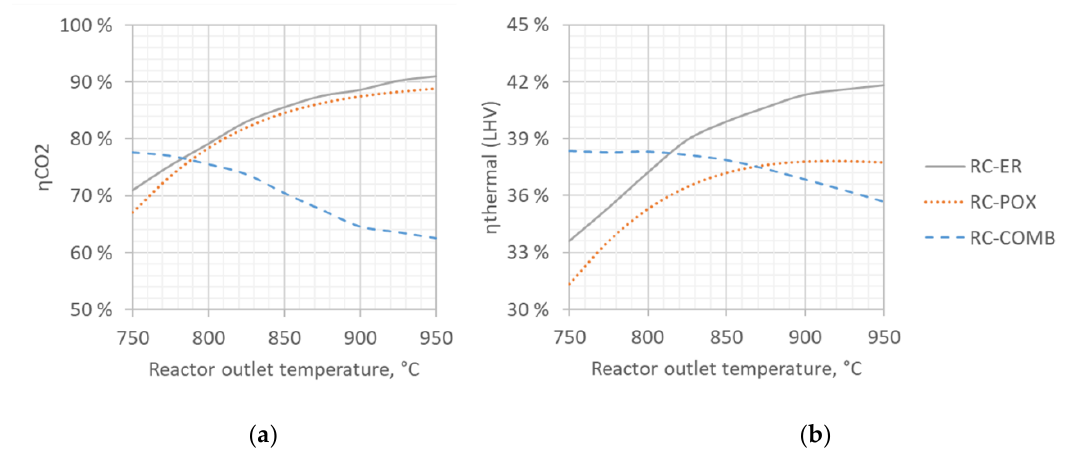
Figure 6. Impact of syngas preparation temperature on η CO 2 (panel a ) and η thermal (panel b ) for the examined process configurations assuming low temperature electrolyzer technology operating at 60% net system efficiency.